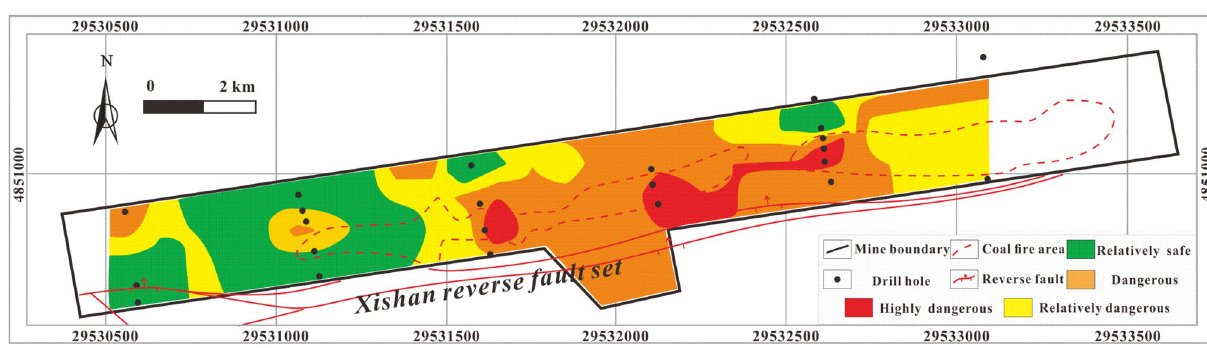
Figure 17. Thematic map of multi-factor superposition in MAPGIS